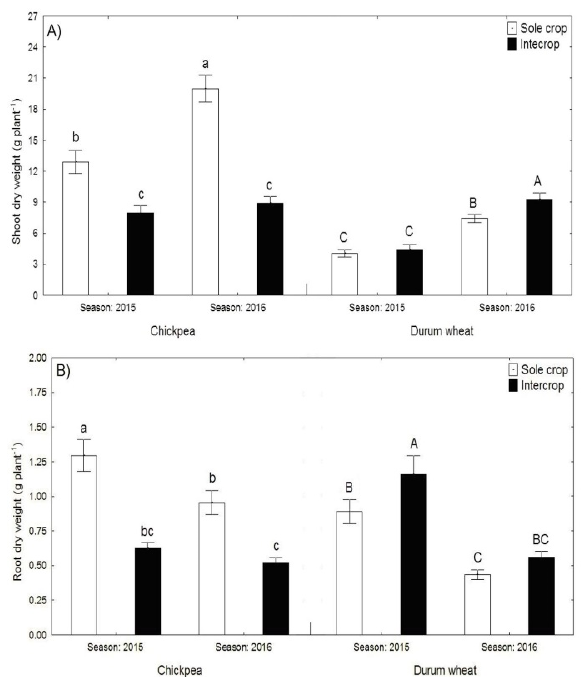
Figure 1. Shoot ( A ) and root ( B ) dry weight of chickpea and durum wheat as sole crops and intercrops in 2015 and 2016. Data are means and standard error (SE) of 25 plants harvested at 120 days after sowing. Bars with the different letters compare cropping systems and years within a crop and are significantly different at p < 0.05.